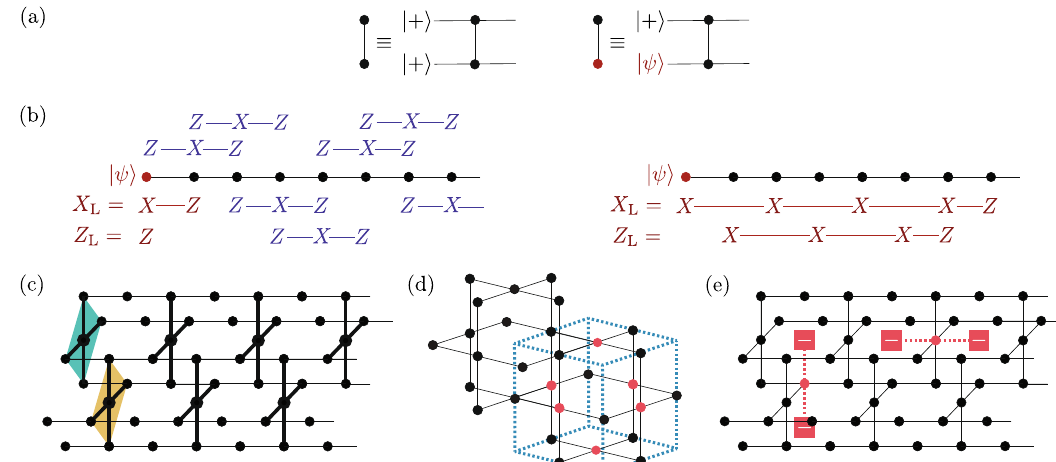
Fig. 2 The standard foliation. a Filled black circles denote qubits initialized in the þj i state, fi lled red circles denote qubits initialized in an arbitrary state. Qubits connected by a line have a CZ gate applied between them. b Left: The logical operators (red) and stabilizers (blue) of the 1D cluster state. Right: By multiplying the logical operators by stabilizers, we can rewrite them to involve only X operators on the fi rst 2 n qubits. Measuring the fi rst 2 n qubits in the X basis teleports logical information to qubits {2 n + 1, 2 n + 2}. c By coupling ancilla qubits (bold) to a set of 1D cluster states, we can measure multi-qubit logical operators during teleportation. Here, measuring the X operator on the ancilla qubits attached at even (odd) numbered sites measures the logical product of the Z ( X ) operators of the neighboring qubits. We thus measure the stabilizers of the surface code as we teleport. d The unit cell of the resulting cluster state, the RHG cluster state. One can verify that the product of X operators on the highlighted qubits is a stabilizer of the RHG cluster state. There is one such stabilizer associated with each cell of the lattice. e A Z error on a qubit fl ips the stabilizers of the neighboring cells, allowing us to detect